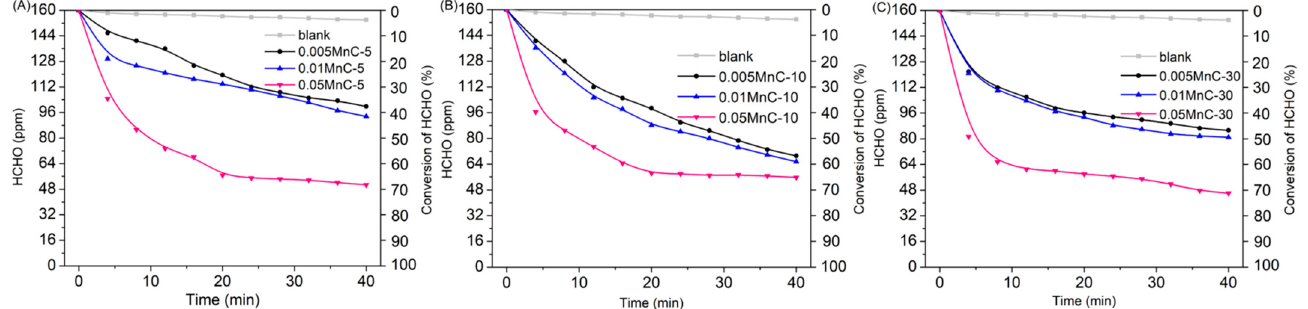
Figure 1. The HCHO elimination rate under xenon light irradiation by Mn-modified CNS catalysts with different synthesis conditions: ( A ) 0.005, 0.01, and 0.05 mol/L of potassium permanganate impregnated for 5 min; ( B ) 0.005, 0.01, and 0.05 mol/L of potassium permanganate impregnated for 10 min; and ( C ) 0.005, 0.01, and 0.05 mol/L of potassium permanganate impregnated for 30 min.